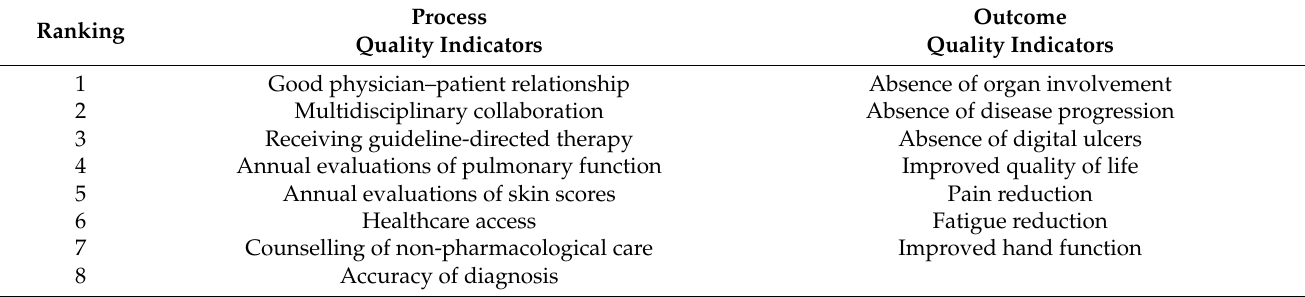
Table 4. Process and outcome quality indicators ranked by SSc